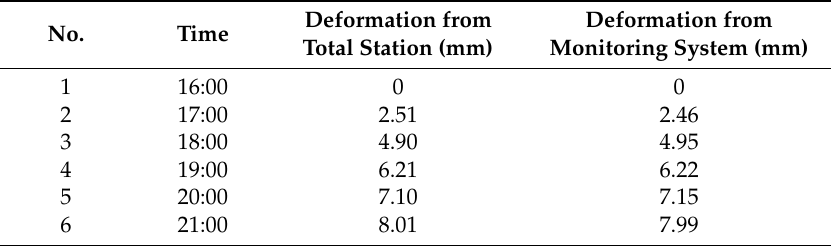
Table 7. Partial field test